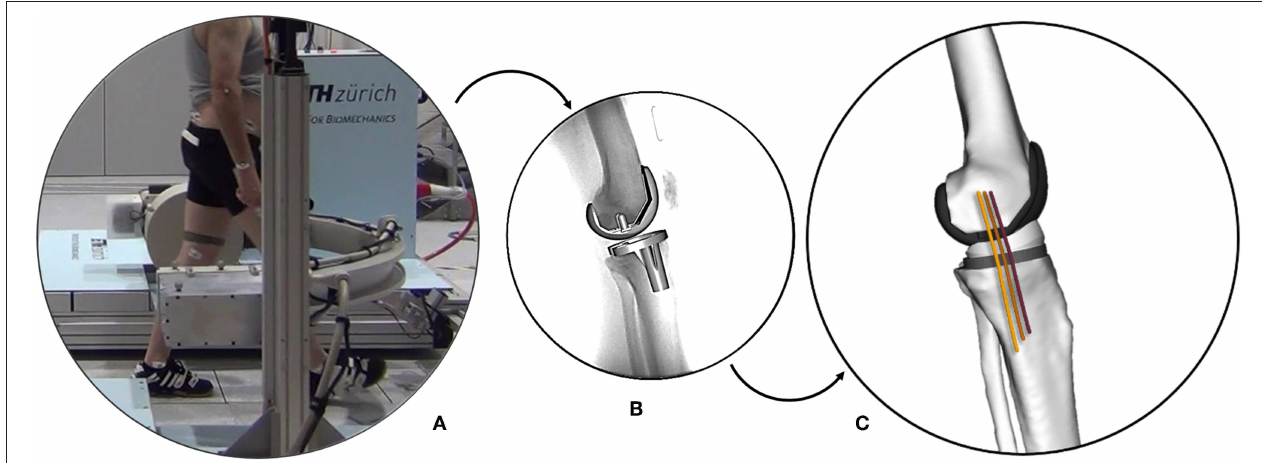
FIGURE 2 | The ETH moving fluoroscope used to capture the knee joints during dynamic activities (A) . Implant component geometries registered to a fluoroscopic image (B) . Multi-body knee model including collateral ligament bundles (C) .